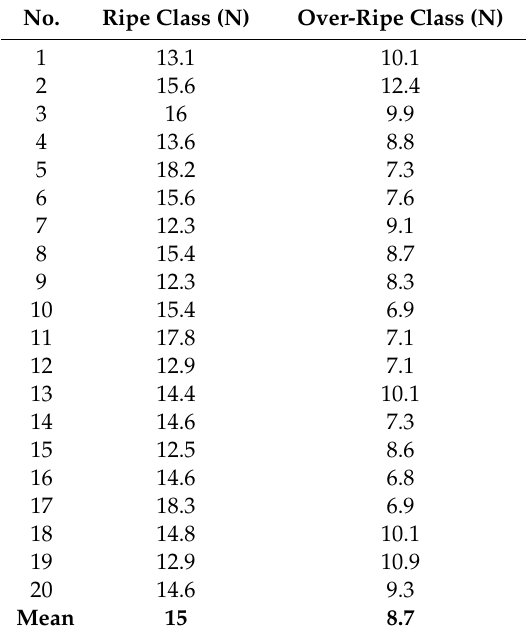
Table 4. Hardness (N) of the selected strawberry classes obtained with TA–XT2i texture analyzer. No. Ripe Class (N) Over-Ripe Class